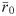
Point pattern generator for target NN distance.A. Illstration of average NN distance for uniform random Poisson distribution of 30 points and arrows indicating the individual NN. Scale bar (upper right) shows average nearest neighbor distance r¯0. B. Movements of 20 such points in the first 5 iterations (from light grey to dark grey) of our point pattern generator towards a clustered (left) and a more regular (right) pattern. C. Number of iterations required in our algorithm to obtain different values of R (0.2 –purple, 0.6 –blue, 1 –yellow, 1.4 –green and 1.8 –brown) from an initial point cloud with 1,000 random points. Dashed lines show target R values. The algorithm stops when the target value of R is reached. D. Sample distributions of 50 points for R = 0.5 (left), R = 1 (middle) and R = 1.5 (right). Scale bars show average nearest neighbor distance r¯0.